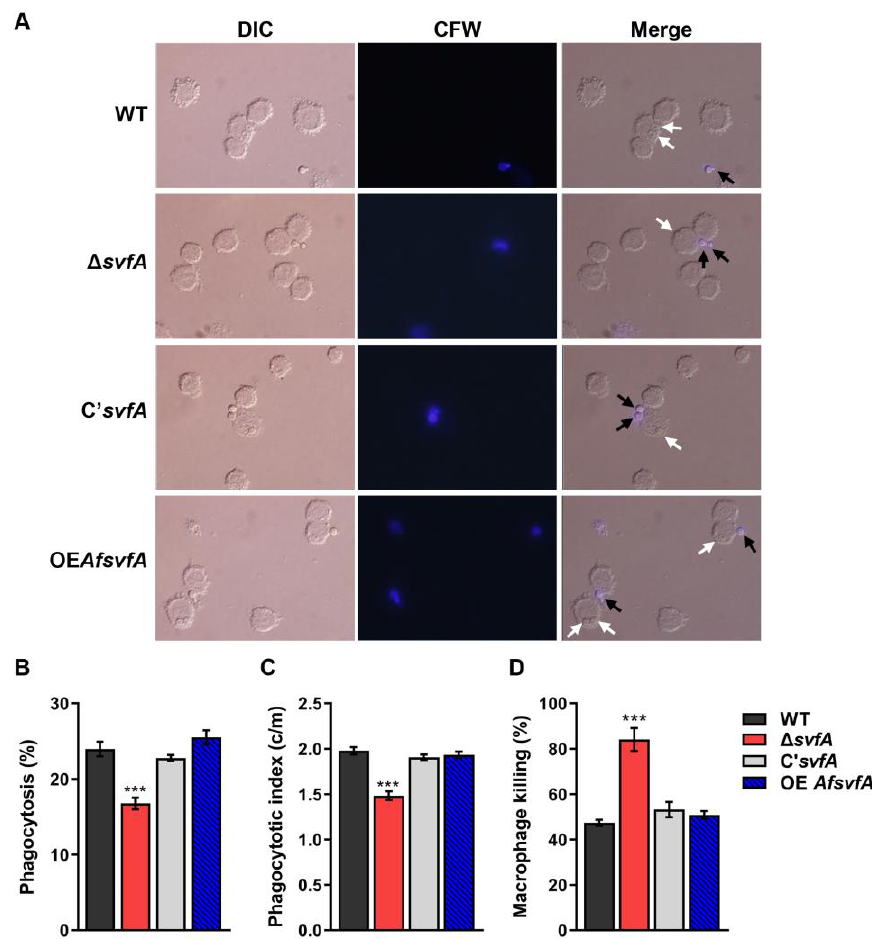
Figure 3. Alveolar macrophage response to ∆ svfA conidia. MH-S murine alveolar macrophage cells were challenged with a three-fold concentration of A. nidulans conidia and incubated for 5 h at 37 ◦ C in an atmosphere of 5% CO 2 . ( A ) Microscopic analysis of the uptake of conidia by the macrophages. External conidia (black arrows) were stained with calcofluor white. White arrows indicate conidia endocytosed by macrophage. ( B ) Phagocytosis of conidia. The percentage of macrophages containing more than one ingested conidia was counted. N = 70 – 150. *** p ˂ 0.001. ( C ) Phagocytic index. The average number of ingested conidia per macrophage (c/m). N = 230 – 400. *** p ˂ 0.001. ( D ) Macrophage killing assay. MH-S cells were stimulated with 10-fold conidia. The cells were incubated for 0 and 16 h at 37 ◦ C in 5% CO 2 . After incubation, macrophages were lysed, serially diluted and plated on GMM agar. Colony-forming units (CFUs) were counted following incubation for 3 d at 37 ◦ C. The percentage of killed conidia (the difference between the number of CFUs from the lysate at 0 and 16 h per the number of CFU from the lysate at 0 h) was calculated. N = 5 – 6. *** p ˂ 0.001.